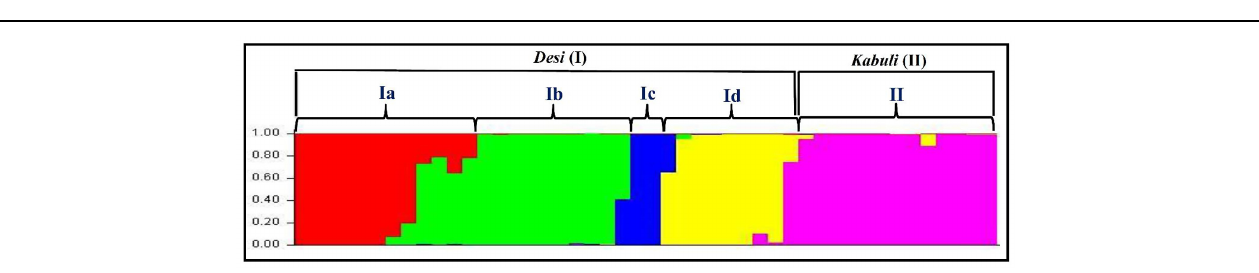
FIGURE 7 | Population genetic structure inferred best possible structure among desi and kabuli chickpea genotypes. The genotyping data of 160 informative genome-wide SSR markers in 31 desi and 15 kabuli chickpea genotypes was used for this analysis. These mapped markers assigned 46 chickpea genotypes into five populations that majorly grouped accordingly by